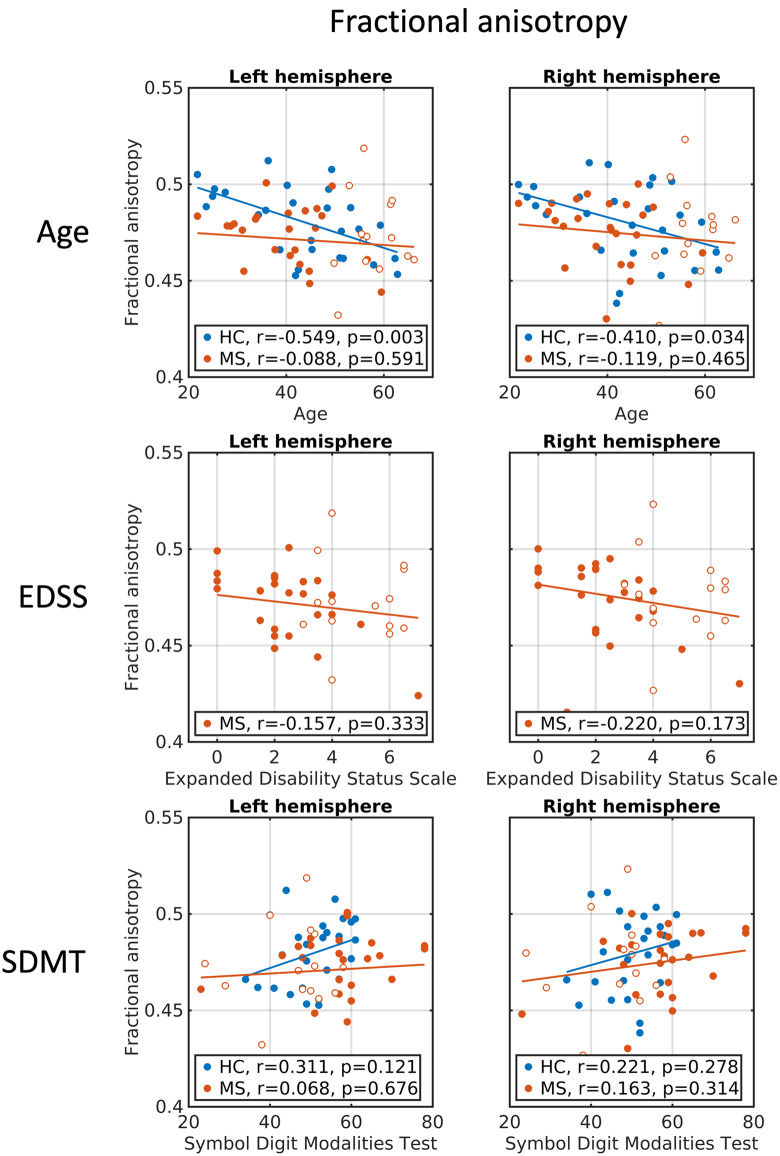

Correlations between FA and clinical/cognitive scores. Age, EDSS and SDMT correlations with FA (slab) averaged within left and right hemispheres of NAWM. First row: correlations with age. Second row: correlations with EDSS. Third row: correlations with SDMT. Blue circles: healthy controls. Full red circles: relapsing-remitting multiple sclerosis patients. Open red circles: primary-progressive multiple sclerosis patients. EDSS = expanded disability status scale; SDMT = symbol digit modalities test.